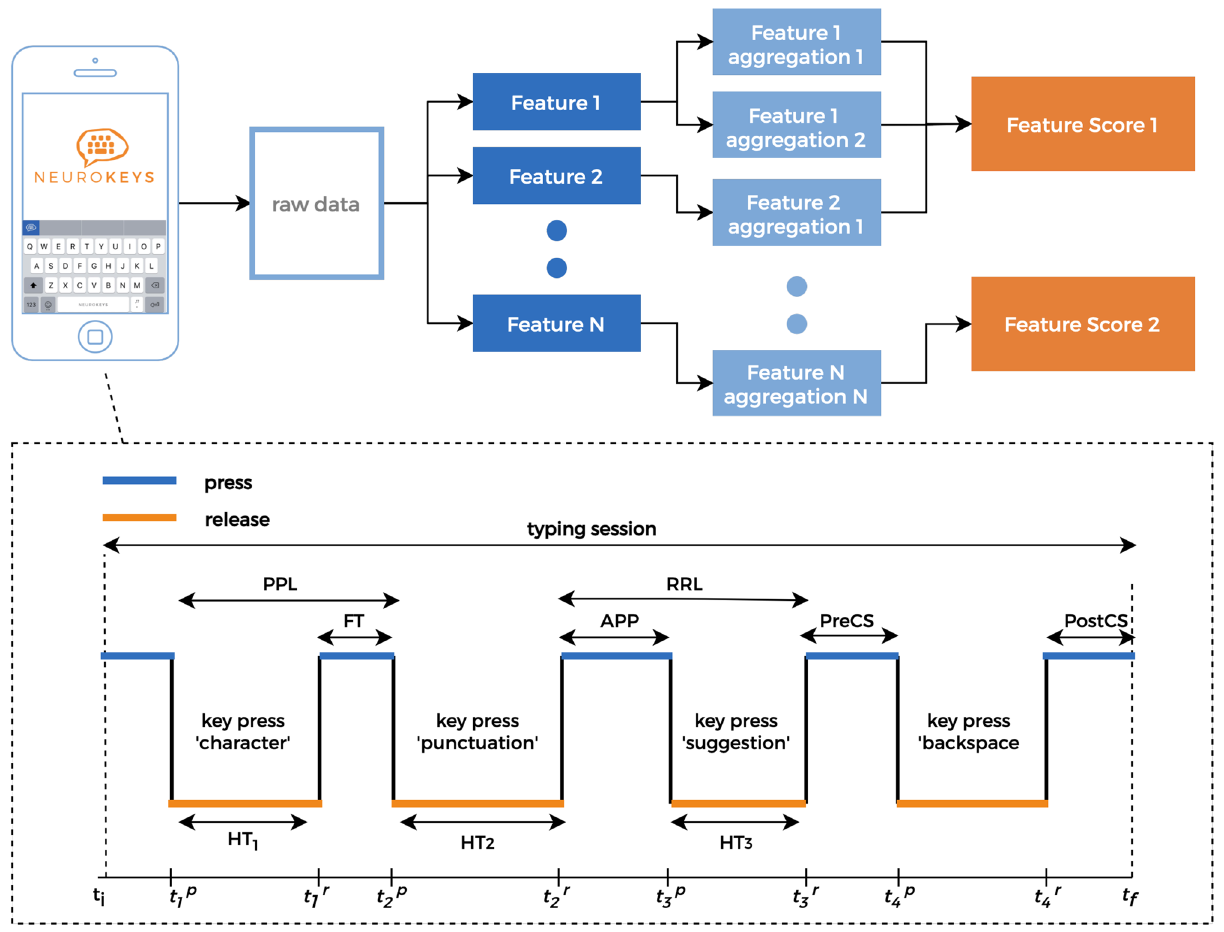
Figure 2. The keystroke data are continuously collected through the Neurokeys app. Various features are constructed from the raw data, and a graphical representation of keystroke sequences is provided. Here, the hold time keystroke variable HT 1,2,3 represents the time for which a key is pressed, whereas the flight time ( FT ) is the time between two key presses. The Pre-Correction Slowing ( PreCS ), Post-Correction Slowing ( PostCS 1 ), and After Punctuation Pause ( APP 1 ) are specific cases of flight time relative to the time before and after a backspace and the time after punctuation. After several preprocessing steps, the keystroke sequences are aggregated on a daily level using summary statistics such as mean and standard deviation (see supplementary material Table